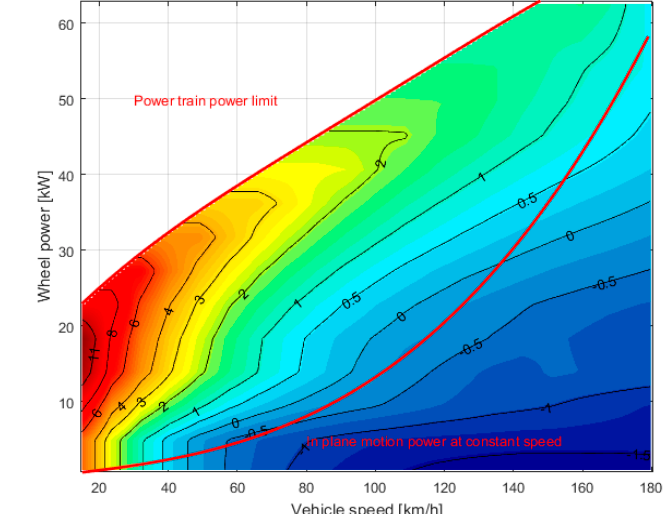
Figure 6. CVT optimization conceptual scheme. Energies 2017 , 10 , 2142